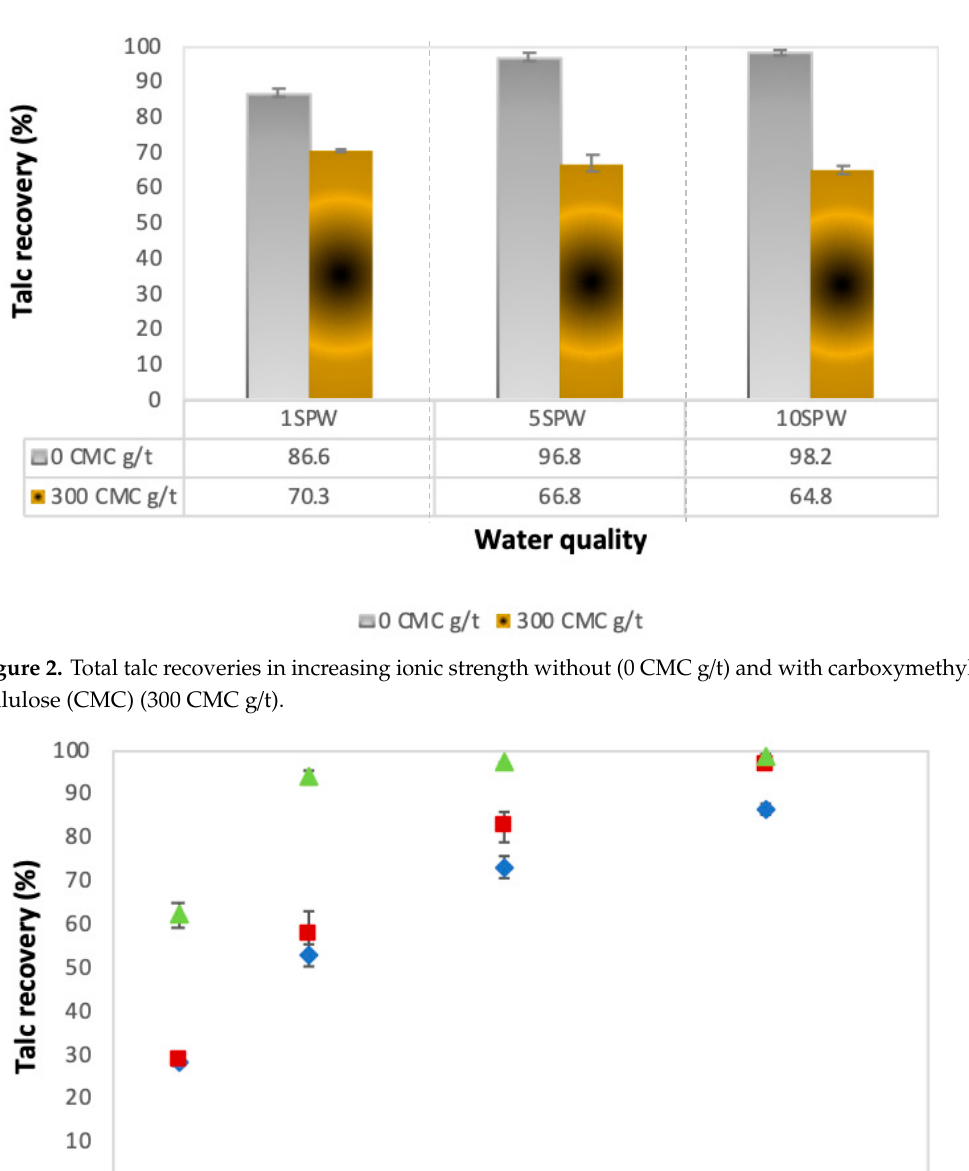
Figure 3. Talc recoveries as a function of time under increasing ionic strength conditions in the absence of CMC (0 CMC g/t).